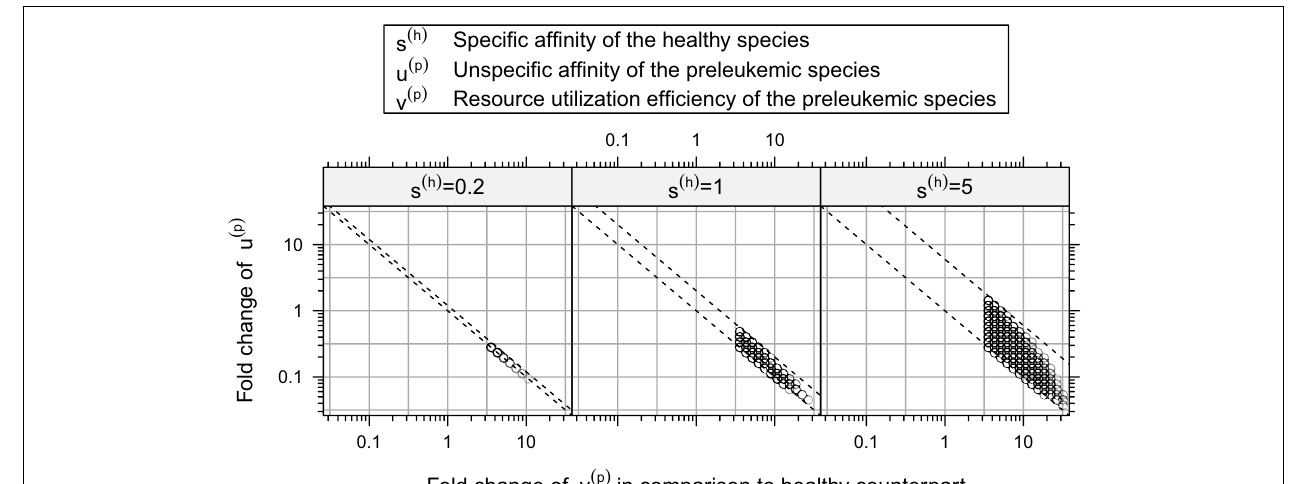
efficiencies v ( t ) .The relation between these quantities is relatively strict. All points are contained between two parallel lines. In this plot, we show additional simulation results, in which also the specific affinity of the healthy cells s ( h ) is